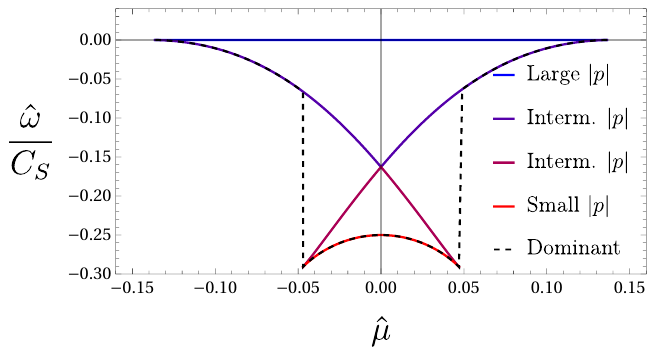
Figure 5. We show ˆ ω with respect to ˆ µ for β = 4 . 333 > β thr and α 1 = 0 , in d = 4 dimensions. There is a region where four phases with different p coexist, and the dominant one is drawn with a black dashed line. At some point there is a zeroth-order phase transition, but there is a maximum value of | ˆ µ | above which no solutions